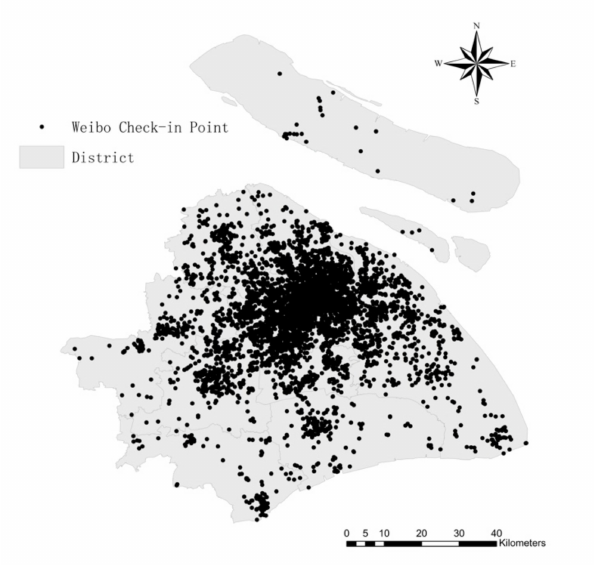
Figure 2. Distribution of Weibo check-in points in